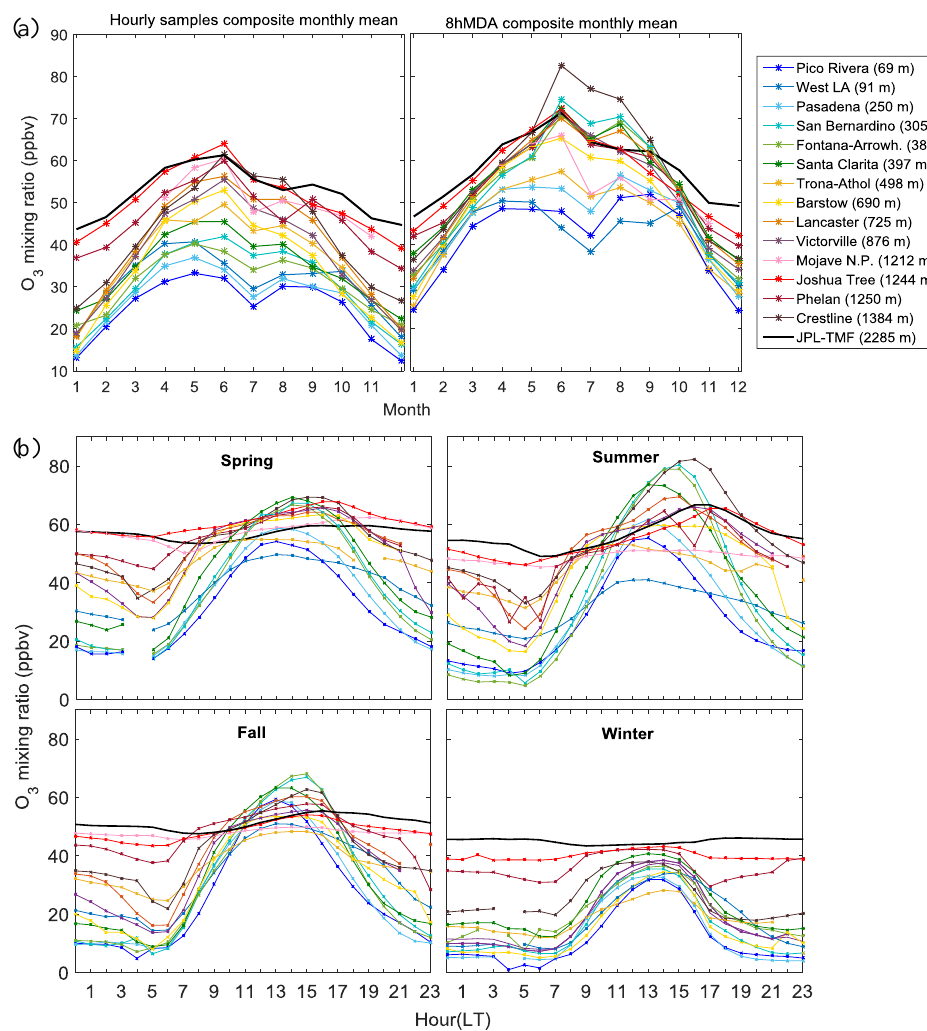
Figure 2. (a) Composite monthly mean surface ozone at TMF and nearby ARB stations obtained from hourly samples (left) and 8hMDA values (right) for the period 2013–2015. (b) Composite mean ozone daily cycle at TMF and nearby ARB stations for the four seasons for the period